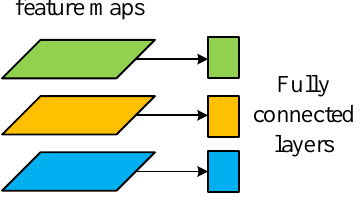
Figure 6. Relation between full connection layers and feature